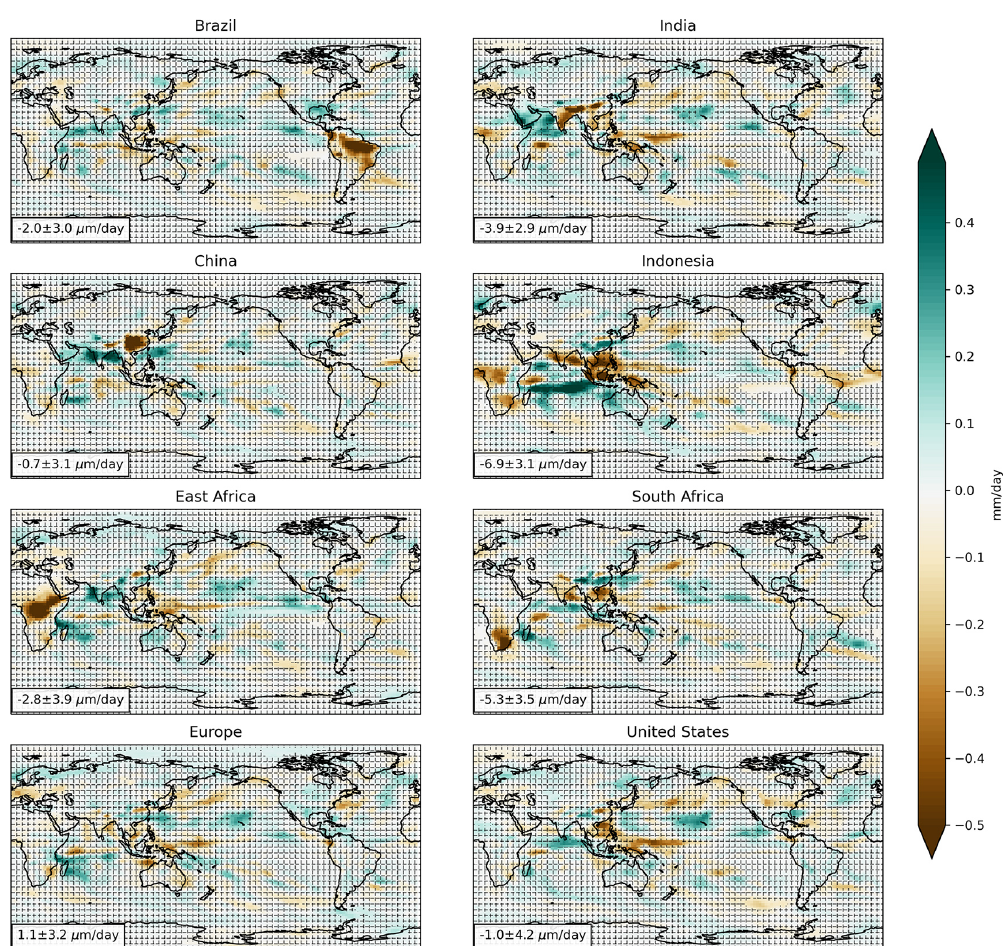
Figure 5. Spatial distribution of the change in the rate of fast precipitation response (mmd − 1 ) due to the addition of an identical aerosol emissions amount and composition in each of the eight regions. Grid lines indicate regions where the changes are not statistically significant at the 95% confidence level via a two-sided t test. Global-mean change in the rate and 95% confidence intervals ( ± 1 . 96 σ ) (µmd − 1 ) of fast precipitation response are shown in the bottom left corner of each